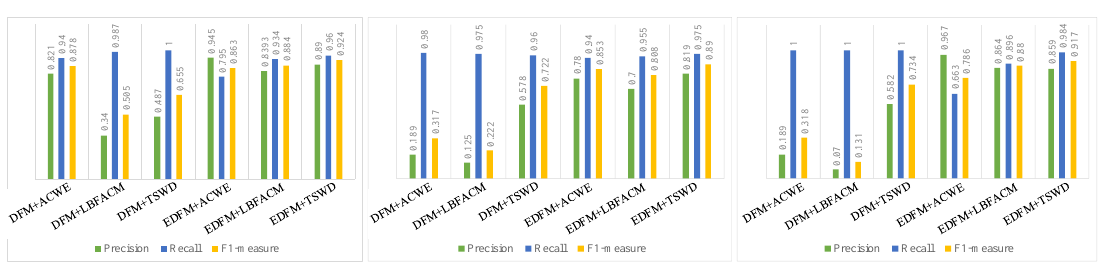
( e ) Quantitative results of row5 in Fig.11 ( f ) Quantitative results of row6 in Fig.11 Figure 12. Accuracy comparison of different competing